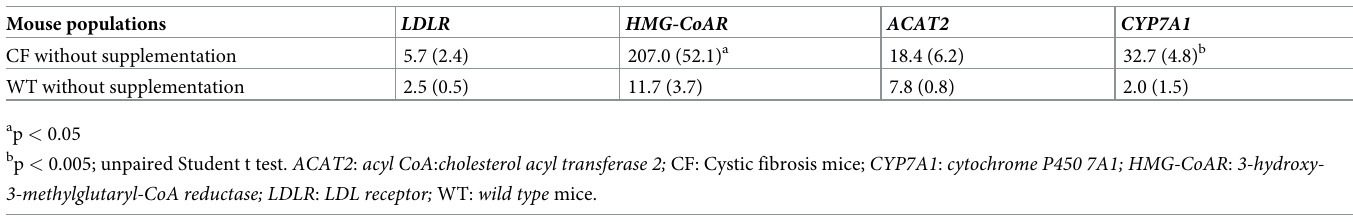
Table 4. Comparison of liver mRNA expression in CF and WT mice without cholesterol-supplementation.